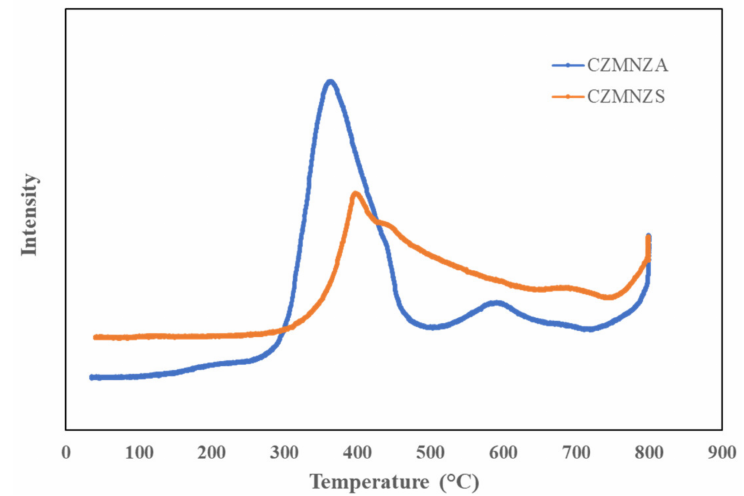
Figure 11. NH 3 -TPD profiles of CZMNZA and